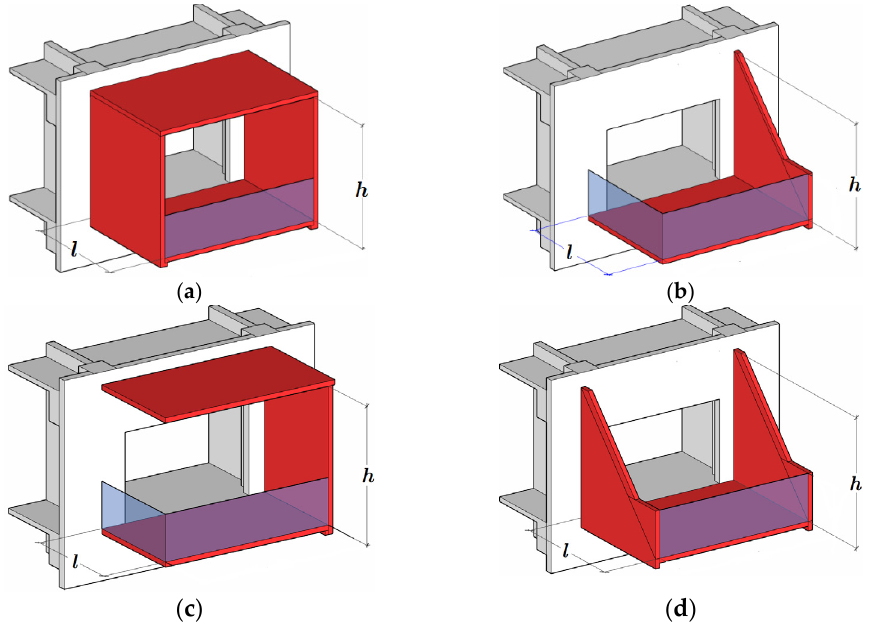
Figure 1. Four structural forms of longer ‐ cantilevered balconies: ( a ) O ‐ shaped, ( b ) L ‐ shaped, ( c ) C ‐ shaped and ( d ) U ‐ shaped.